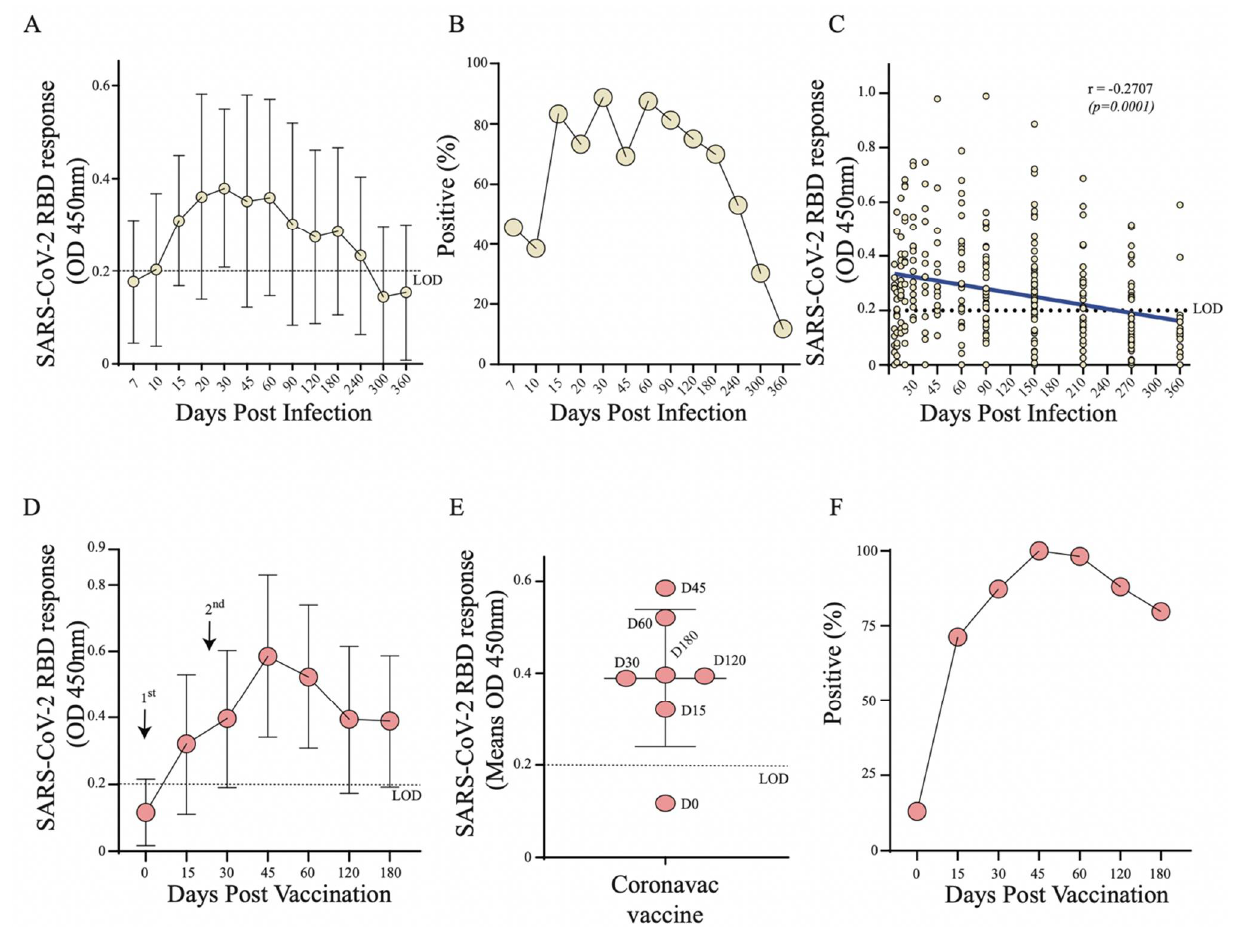
Figure 2. Monitoring of SARS-CoV-2 RBD specific antibodies through ELISA in Group 1 ( n = 116) and Group 2 ( n = 96). ( A ) Curve of RBD specific antibodies in SARS-CoV-2 naturally infected individuals (Group 1); ( B ) Percentage of seroconversion in SARS-CoV-2 infected individuals (Group 1); ( C ) Linear regression analysis of anti-RBD antibodies over 12-months from the day of infection by SARS-CoV-2 (Group 1); ( D ) Curve of RBD specific antibodies in CoronaVac vaccinated individuals (Group 2); ( E ) Distribution of OD means post vaccination (Group 2); ( F ) Percentage of seroconversion in CoronaVac vaccinated individuals (Group 2).